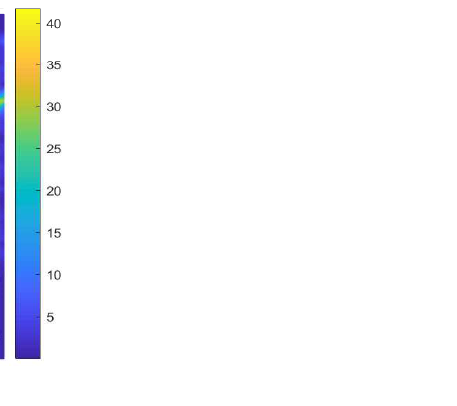
Figure 18. Time-frequency distribution of compensated signal when there is a Doppler frequency.